Question: Describe this figure in one sentence.
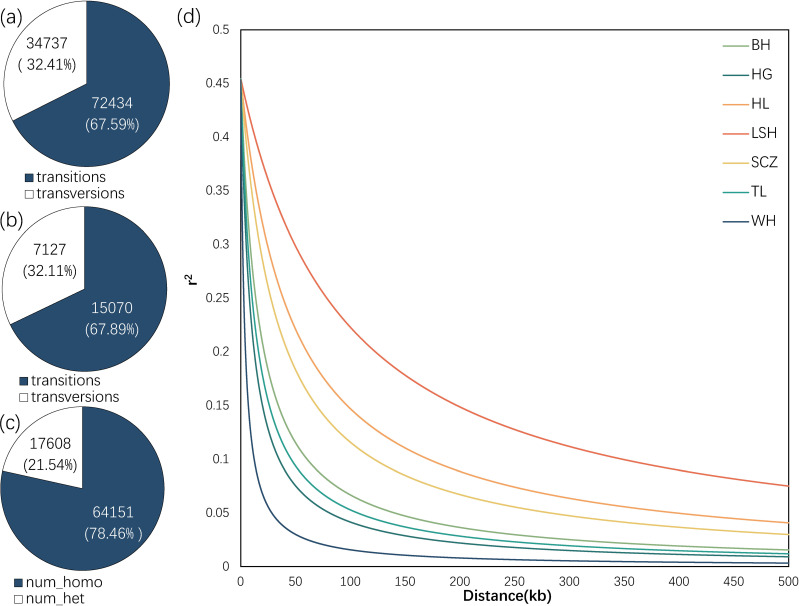
Answer: Characterization of filtered variant sites and LD-decay. (a) Statistics of the number of variant sites across all samples in the filtered VCF. Transitions: the total number of sites where transitions occur; transversions: the total number of sites where transversions occur. (b) Statistics of the mean number of variant sites per sample in the filtered VCF. (c) The mean number of genotypes per sample. num_het: the number of heterozygous genotypes; num_homo: the number of homozygous genotypes. (d) LD-decay of all populations. Distance: spacing between SNPs. r2: the coefficient of LD. Population abbreviations: BH Bohai, HG Hegang, HL Helong, LSH Lushuihe, SCZ Sanchazi, TL Tieli, WH Weihe.